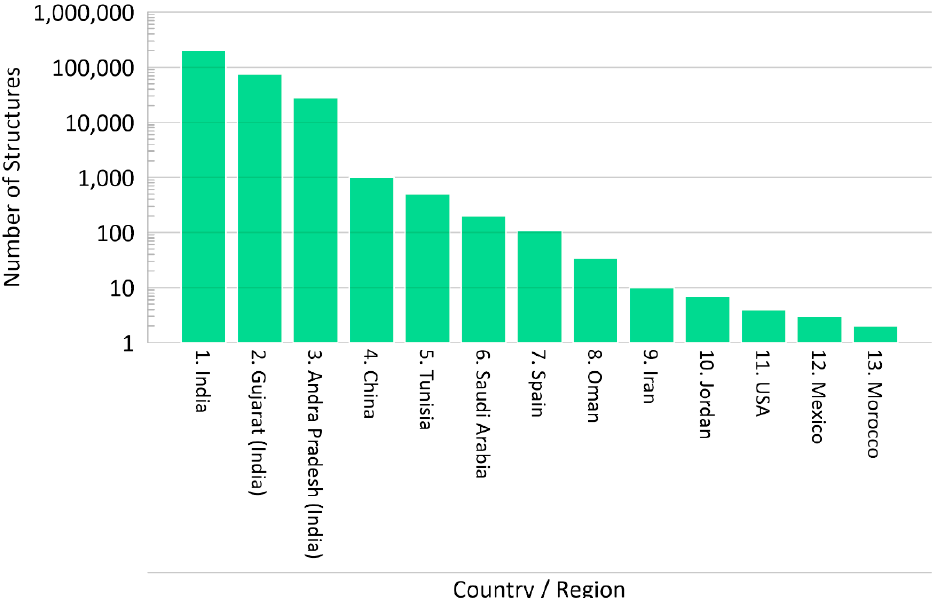
Figure 2. Recharge dam occurrence identified through the literature review.